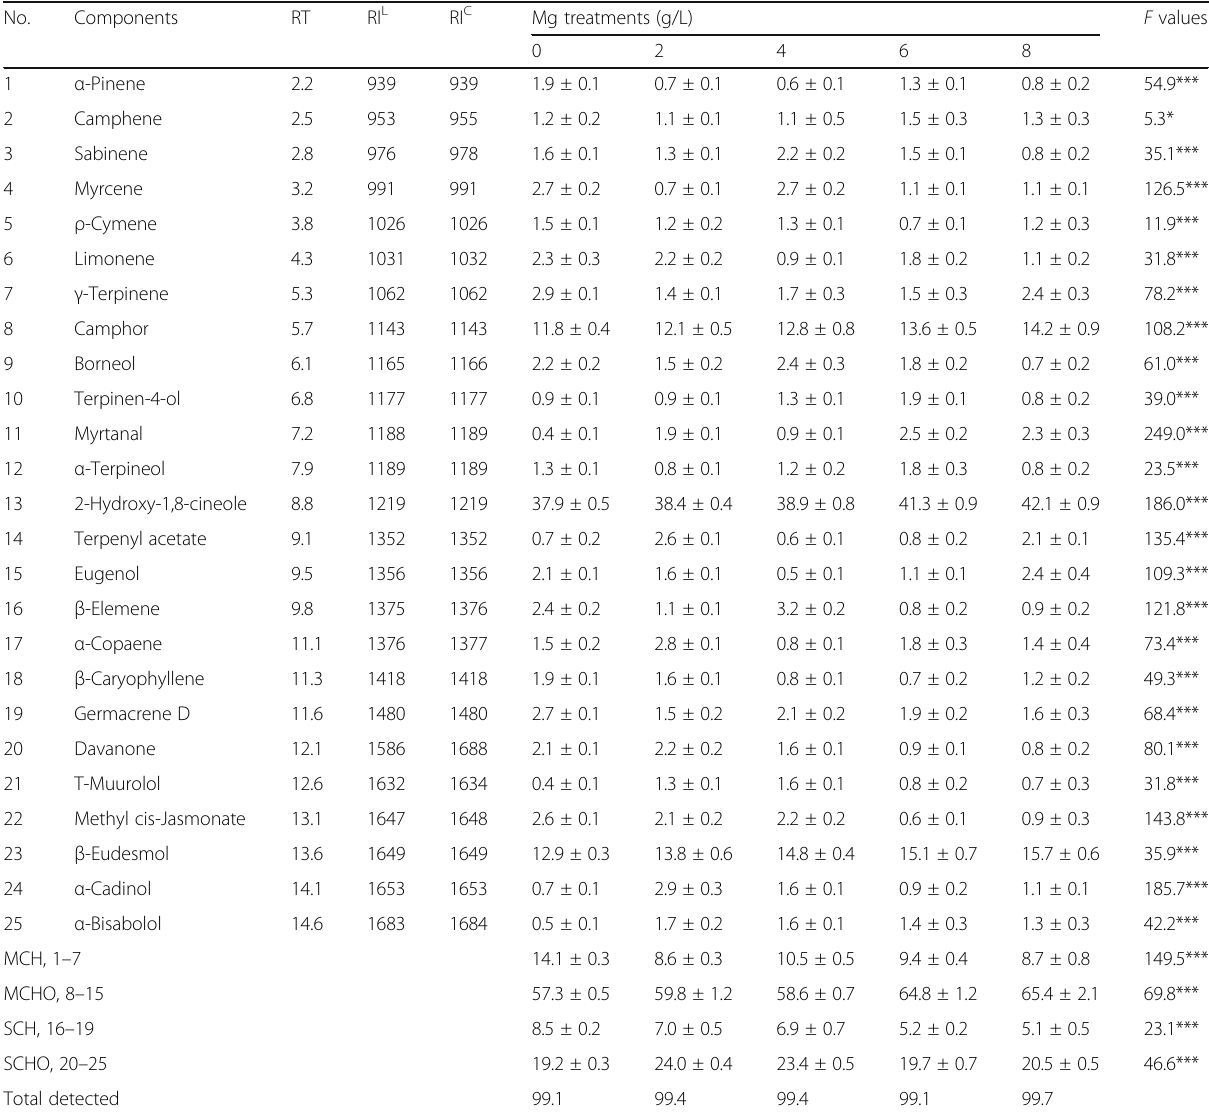
Table 4 Effect of Mg treatments on EO